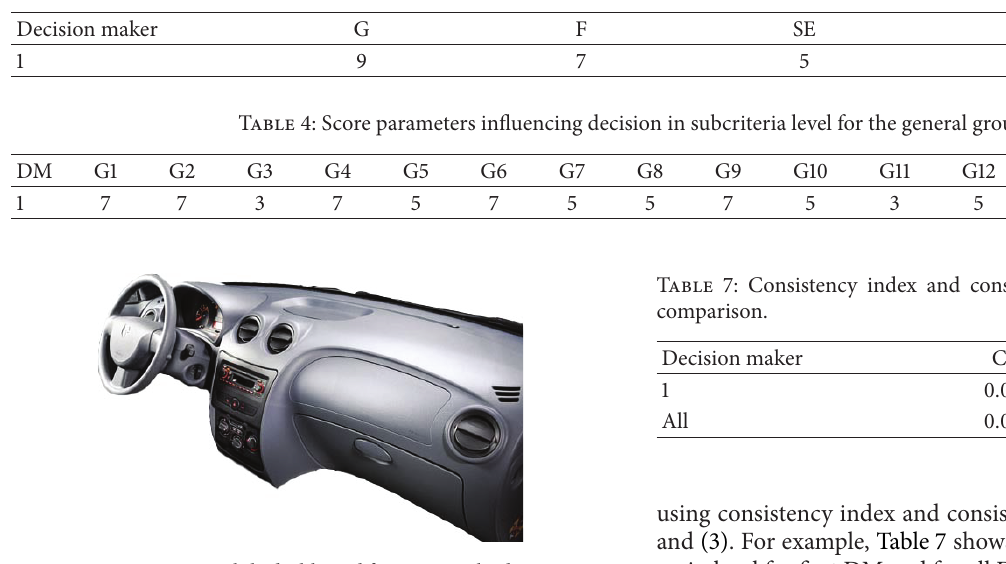
Table 3: Score parameters influencing decision in main criteria level.